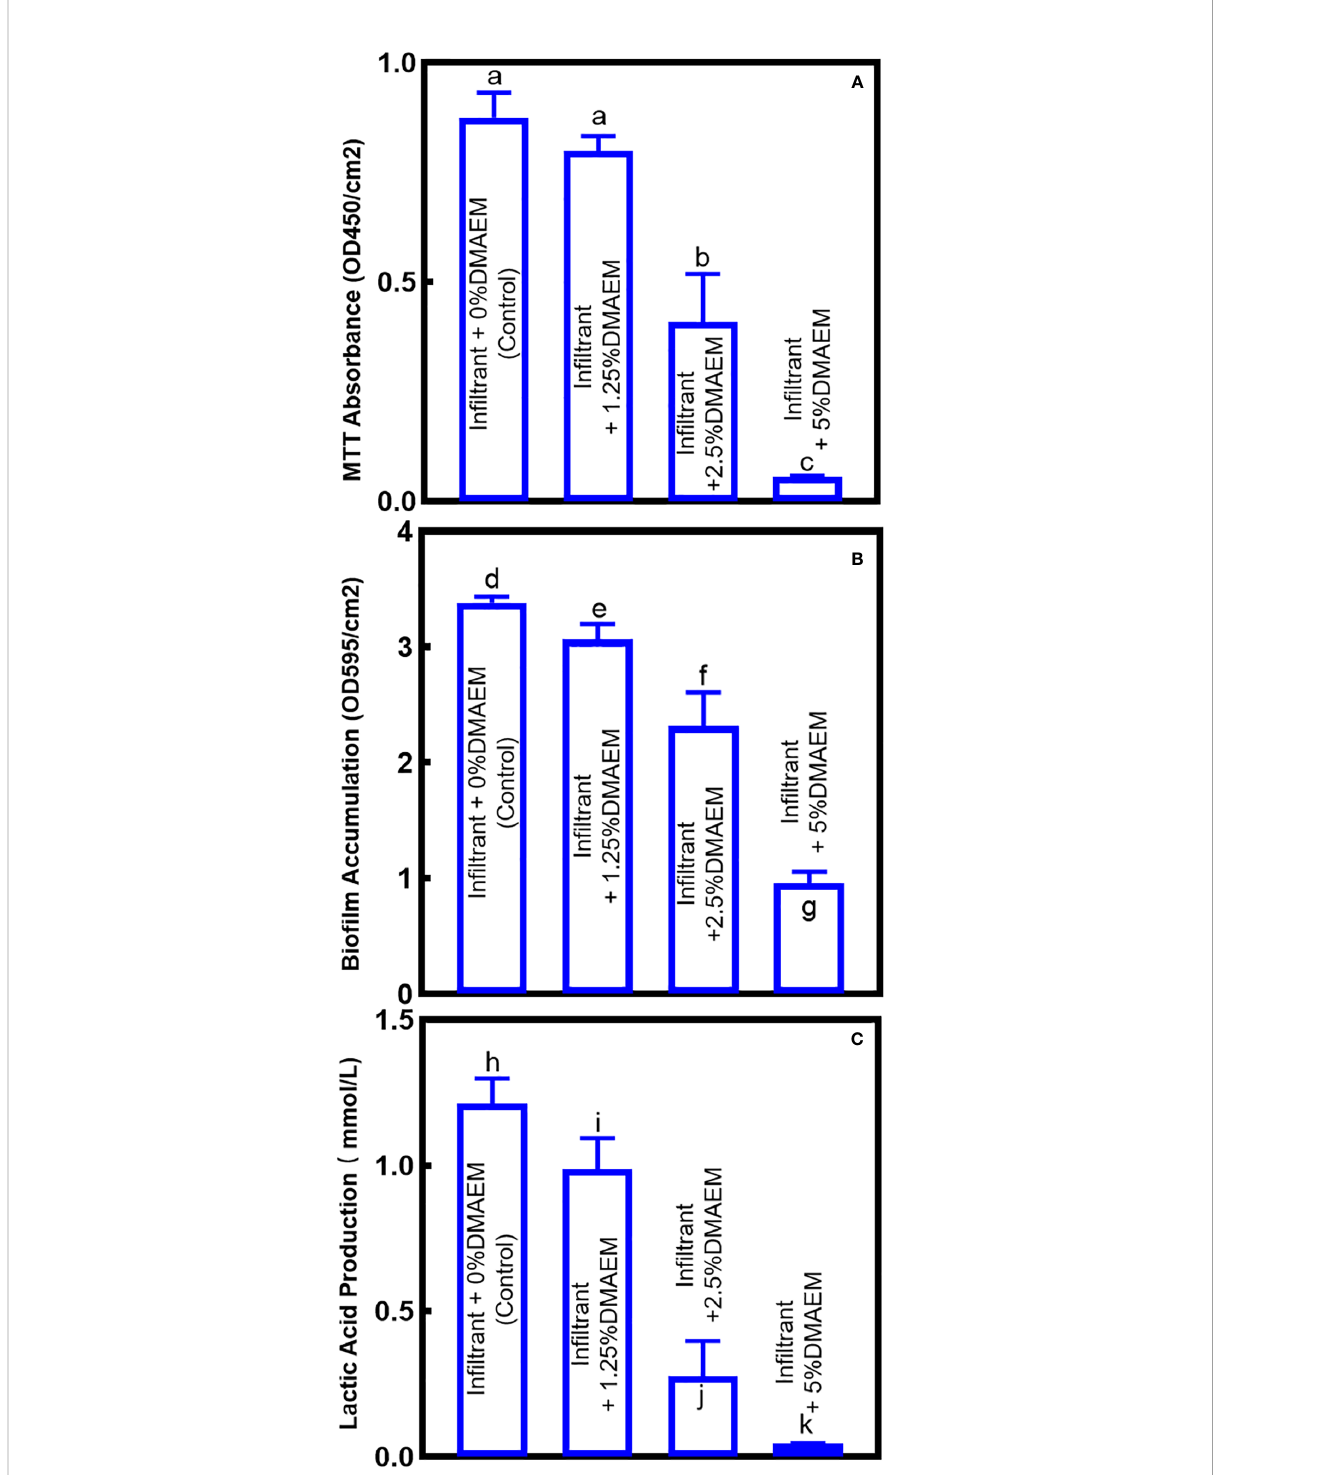
FIGURE 4 Antibacterial effects of composites on saliva-derived bio fi lm. (A) The bio fi lm metabolism evaluation, (B) bio fi lm accumulation, (C) production of lactic acid of the bio fi lm sites (mean ± SD; n = 6). The different letters indicate the signi fi cant difference between the bars (a, b,